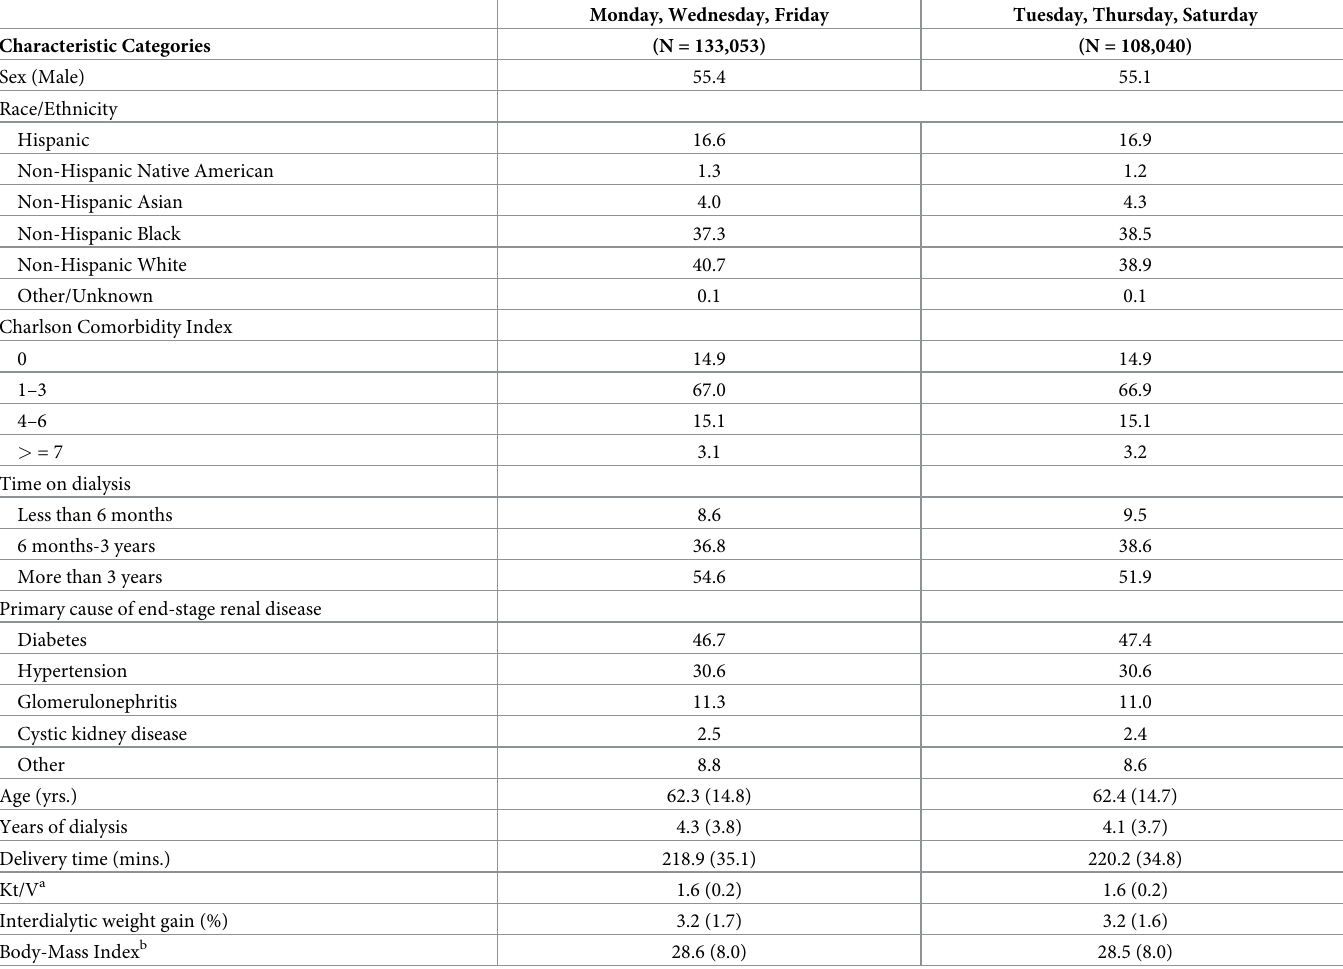
Table 1. Summary of demographic characteristics [percentage or means (standard deviation)] of in-center HD patients by dialysis schedule, in